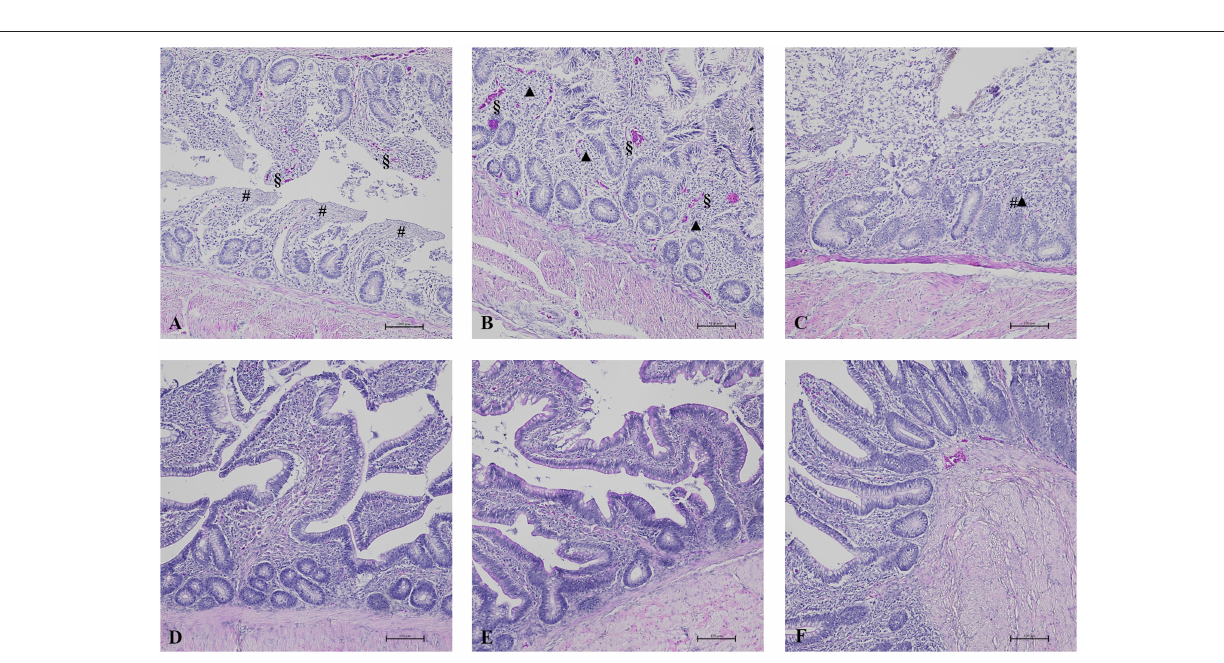
FIGURE 2 | HE results in broilers of zootechnical trial. In AM-treated groups, ileum (A) showed diffuse and severe epithelial detachment (#) associated with hyperemia (§) (HE, 100x) and cecum (B) showed severe and diffuse epithelial fusion ( N ) of the villi associated with focal epithelial detachment of the villi (#) and hyperemia (§) (HE, 100x). Colon (C) was characterized by severe and diffuse epithelial fusion of the villi ( N ) associated with severe and diffuse epithelial detachment of the villi (#) (HE, 100x). These HE results were compared to the normal aspect of intestinal villi and epithelium of the respective intestinal tract observed in K group (D–F) .